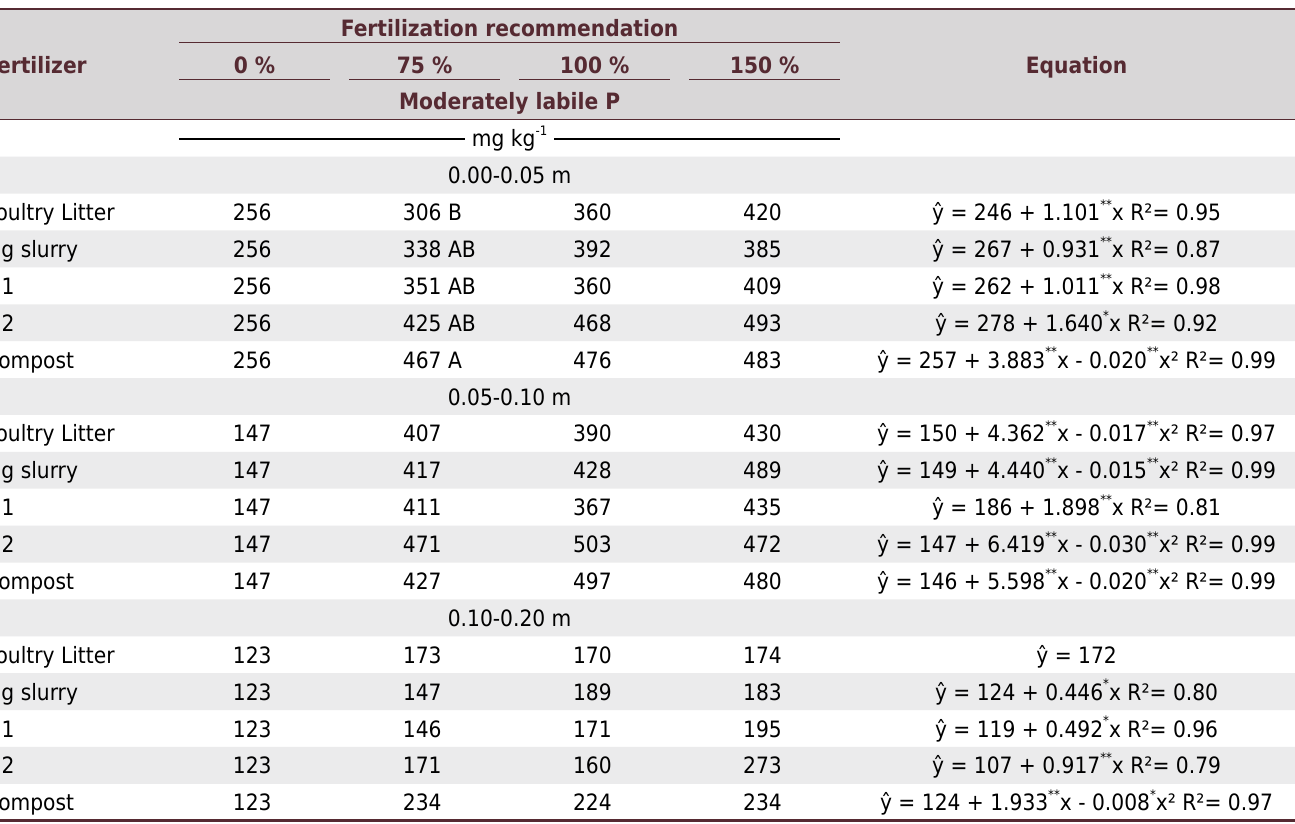
Table 6. Moderately labile soil phosphorus fraction extracted by NaOH 0.5 mol L -1 in the 0.00-0.05, 0.05-0.10, and 0.10-0.20 m layers after six years use of organic and mineral fertilizers in a Rhodic Kandiudox